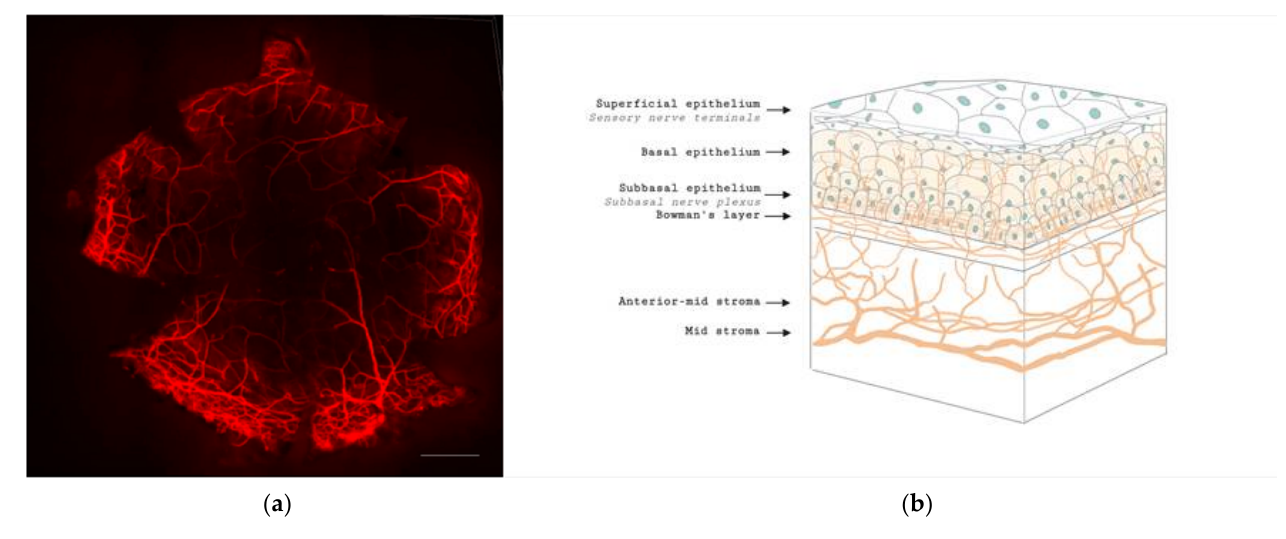
Figure 1. Anatomy of corneal nerves. ( a ) Whole mount staining with anti-class β III tubulin of mice cornea showing the distributions of corneal nerve. Scale bar: 500 µm. ( b ) Cross section of corneal nerves. Figure 1b is created by Biorender.